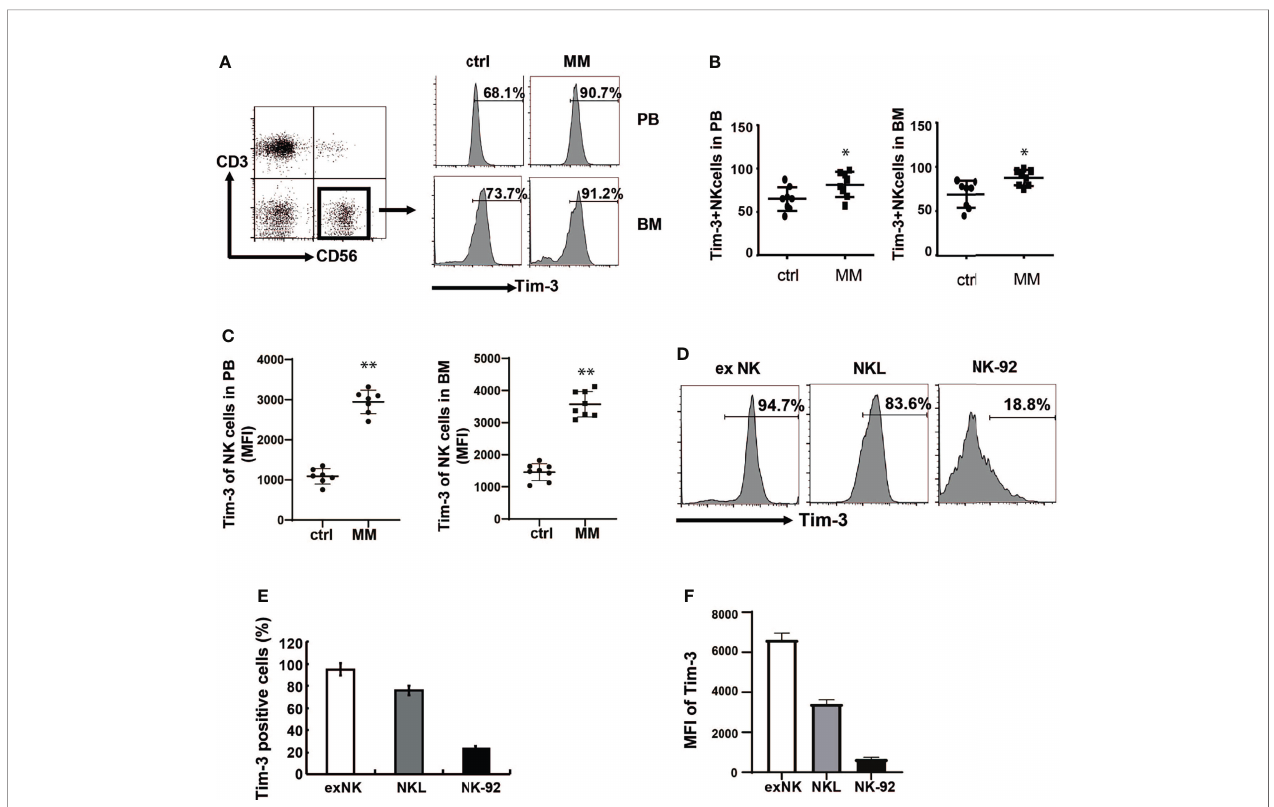
FIGURE 1 | Tim-3 expression in primary NK cells and NK cell lines. Tim-3 expression was quanti fi ed by fl ow cytometry. (A) Tim-3 expression in the BM and peripheral blood NK cells of MM patients and control donors. Freshly isolated hPBMCs and hBMMCs were stained with CD3, CD56, Tim-3, and analyzed for the proportion of Tim-3 + NK cells. (B, C) Statistical analysis of the proportion of Tim-3 + NK cells and the MFI of Tim-3 in NK cells (n=8). (D – F) The expression of Tim-3 in exNK, NKL and NK-92 cells. One representative results from at least three independent experiments were presented. Data shown were mean ± SD of at least three independent experiments. * P < 0.05, ** P < 0.01 versus control NK